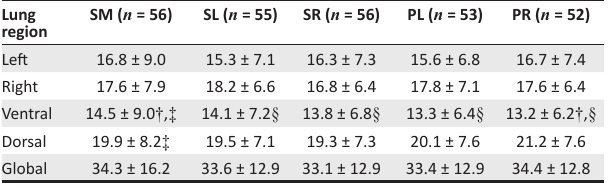
TABLE 2: Mean relative impedance change (± standard deviation) as measured in different lung regions in prone and supine positions, including different head positions.